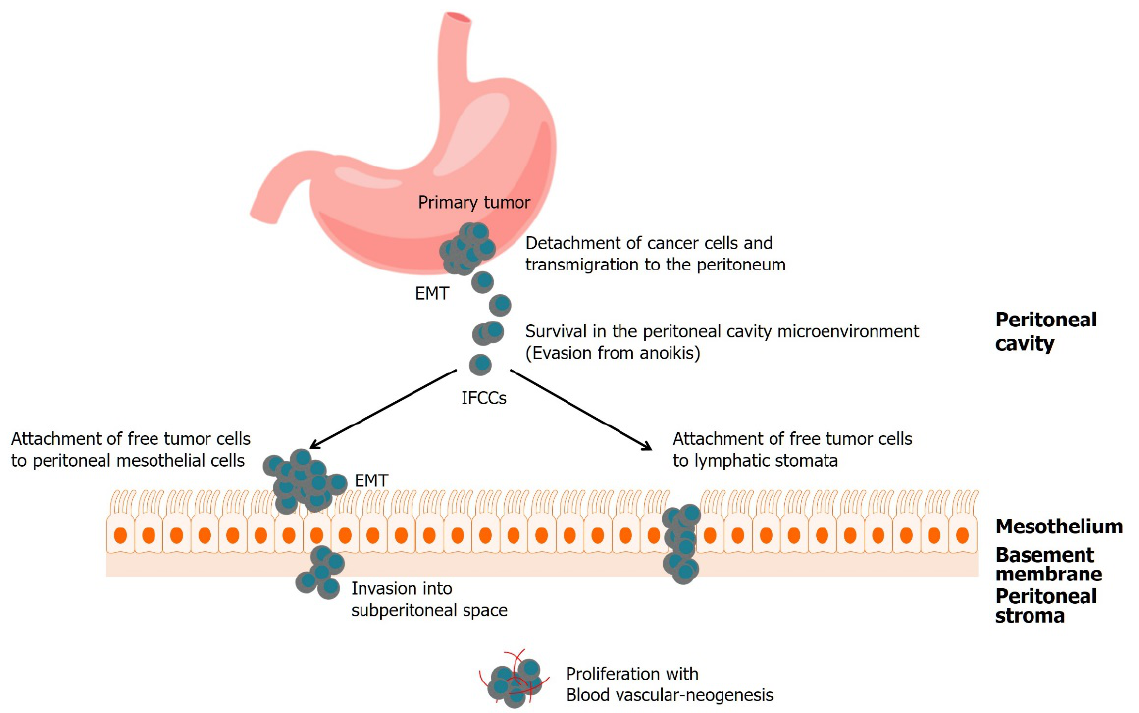
Figure 1. Process of peritoneal metastasis of gastric cancer.